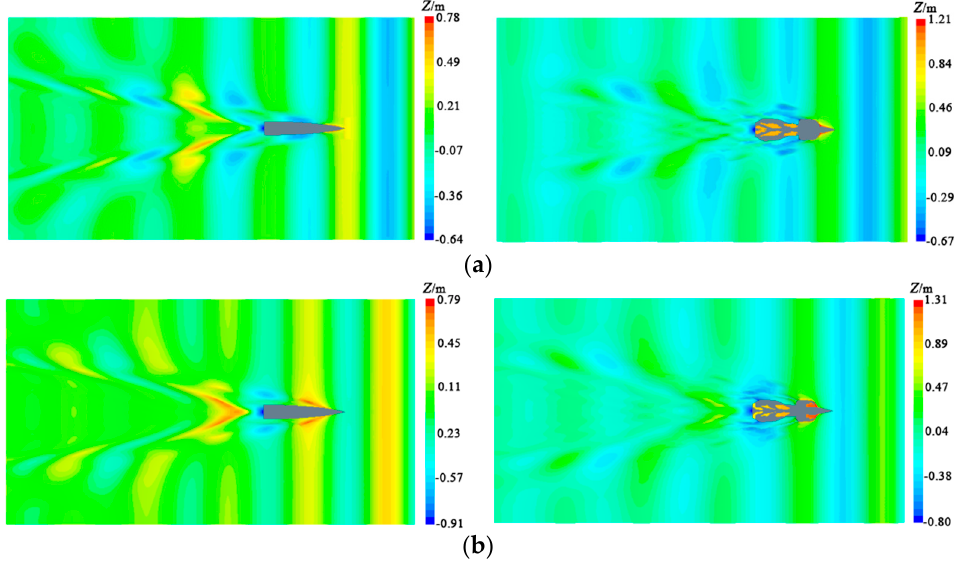
Figure 27. The wave patterns of the monohull and pentamaran in regular waves under case 2: ( a ) bow encounters a wave crest; ( b ) bow encounters a wave trough.